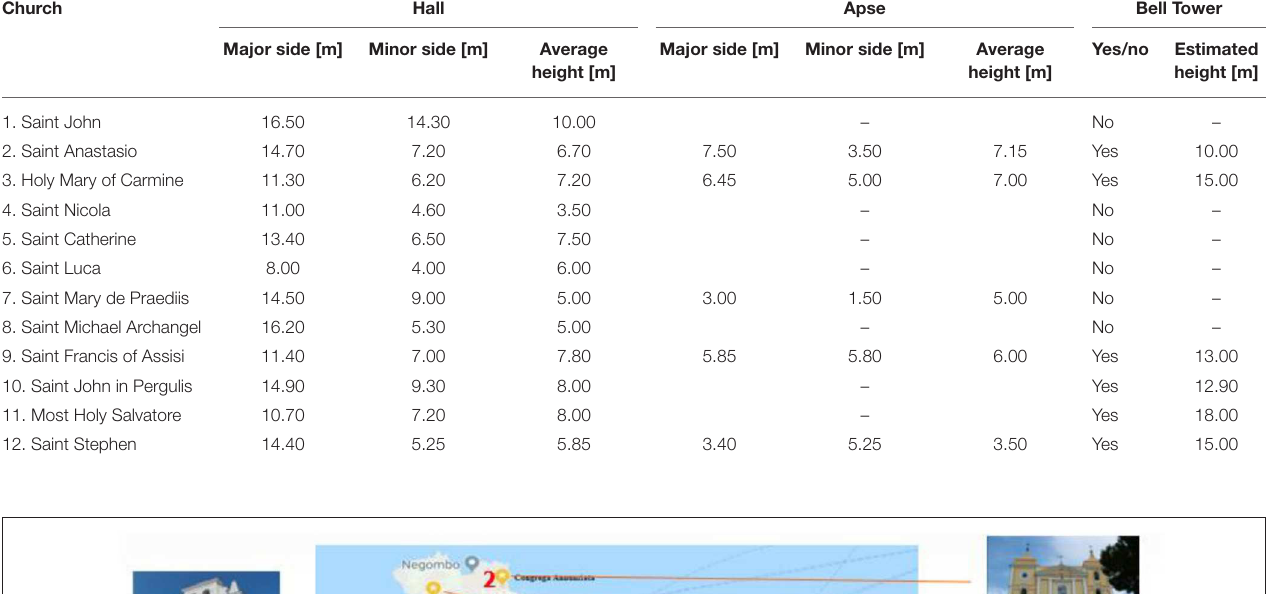
TABLE 4 | Geometrical features of churches investigated in Teramo. Church